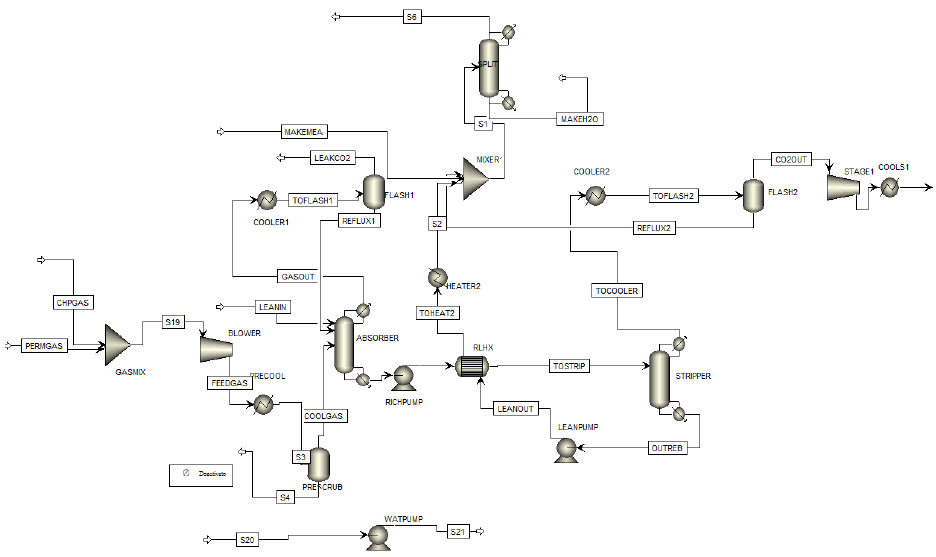
Figure A1. Flowsheet of the CO 2 capture plant model in Aspen Plus (I/II): Main capture plant.